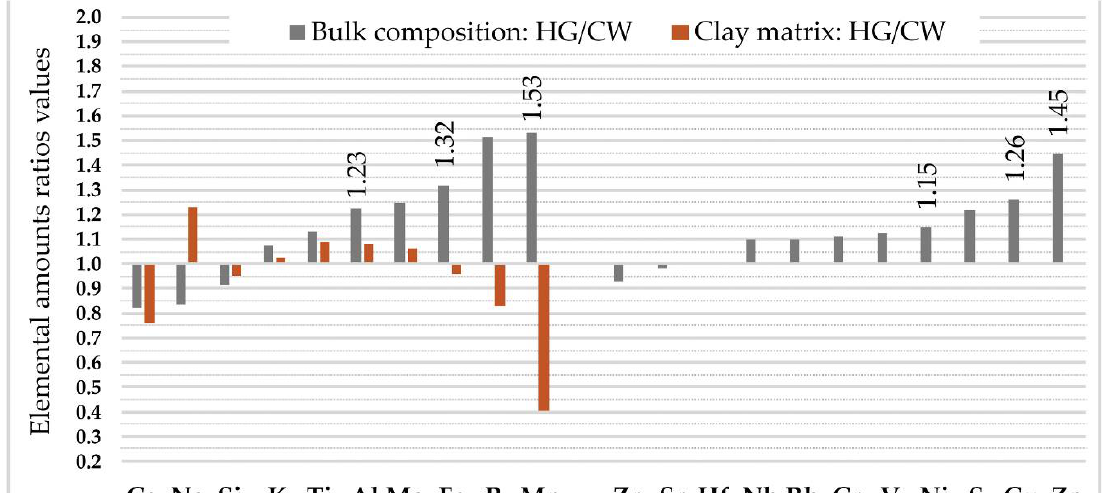
Figure 6. Elemental ratio values of hunter-gatherer pottery (HG) and Corded Ware (CW) in bulk and clay matrix compositions. For calculation ratio values, the median amount of analyte in HG was used as a numerator, whereas the median amount of analyte in CW was as used as the denominator. Analytes are given in ascending sequences of median values of ratios of bulk compositions separately for major analytes (Ca, …, Mn), and separately for trace elements (Zr, …, Zn). If the level of significance of the p -value is between 0.01 and 0.05 (0.01 < p < 0.05), the ratio median value of the corresponding analyte is shown as a number.